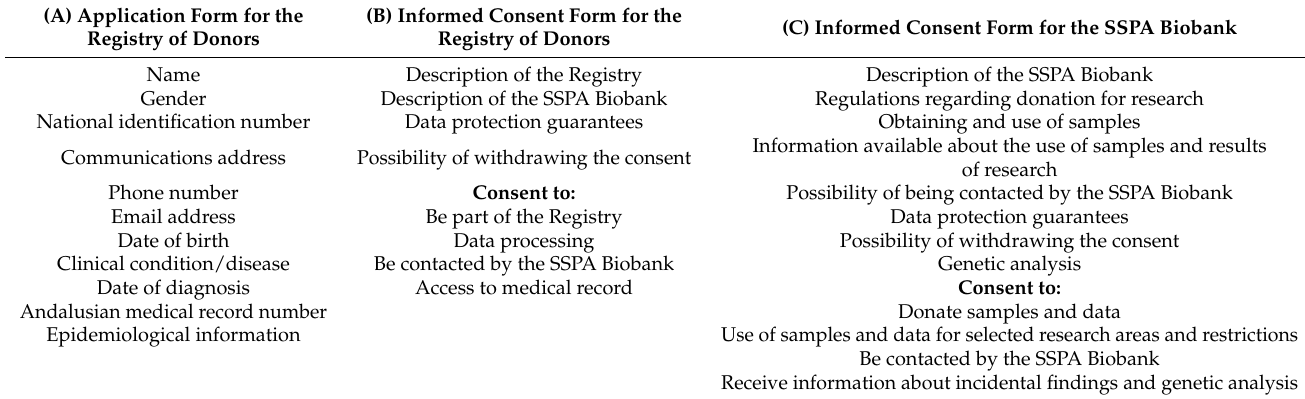
Table 1. Information included in the application form (A) and informed consent form of the Andalusian Registry of Donors for Biomedical Research (B), as well as in the informed consent form of the SSPA Biobank (C).